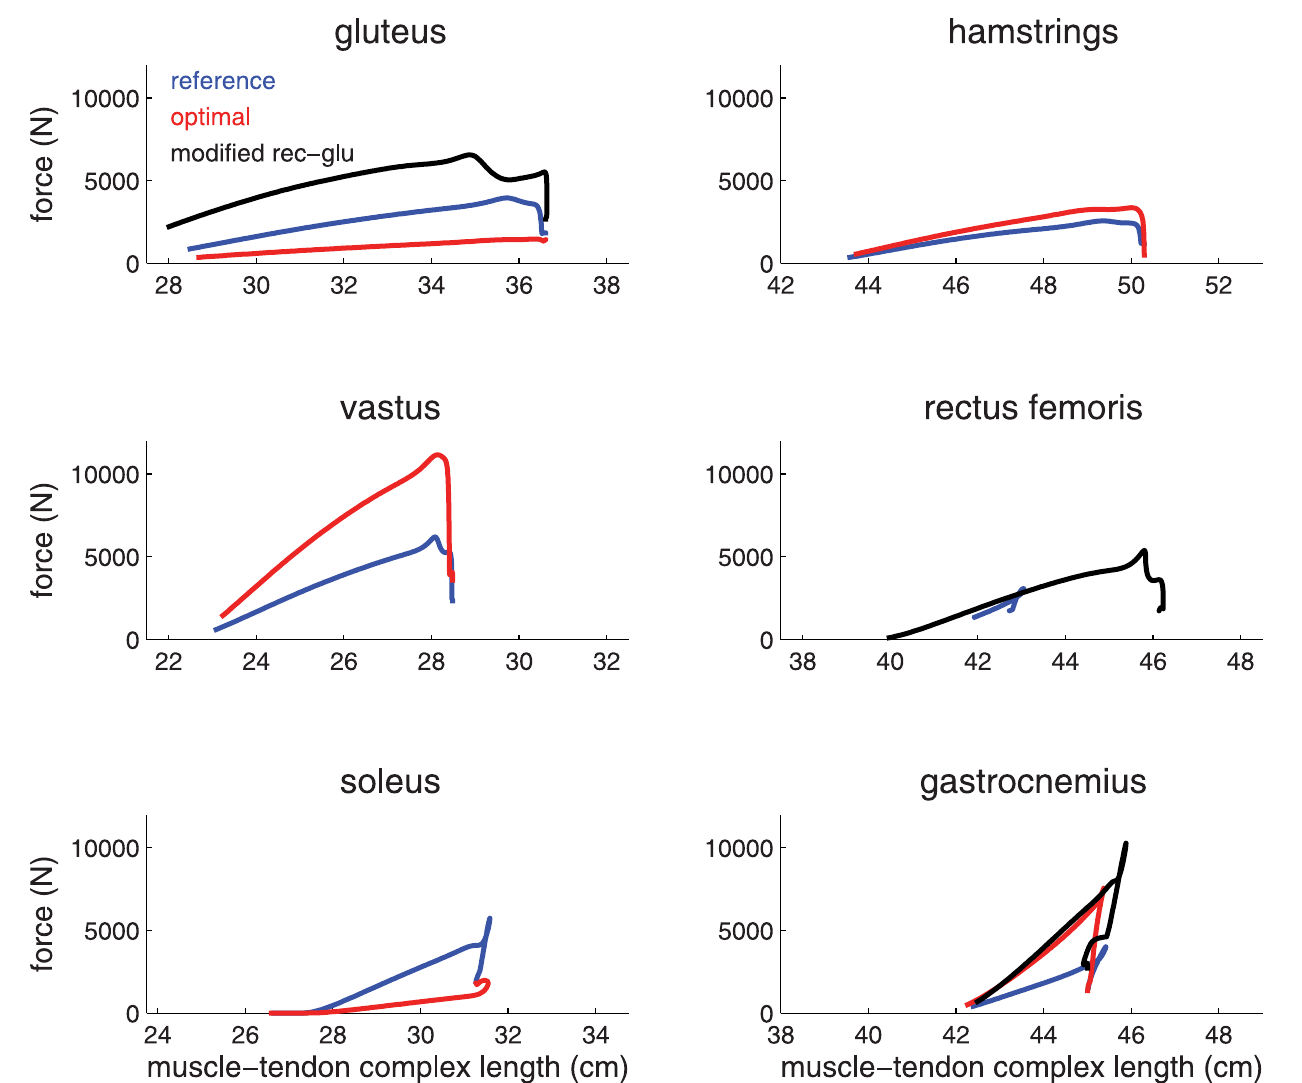
Fig 6. Muscle work for muscles of the reference, optimal, and modified model. The force as a function of muscle-tendon complex length is plotted for each of the six muscles in the reference (solid), optimal (dash-dot), and modified (dotted)